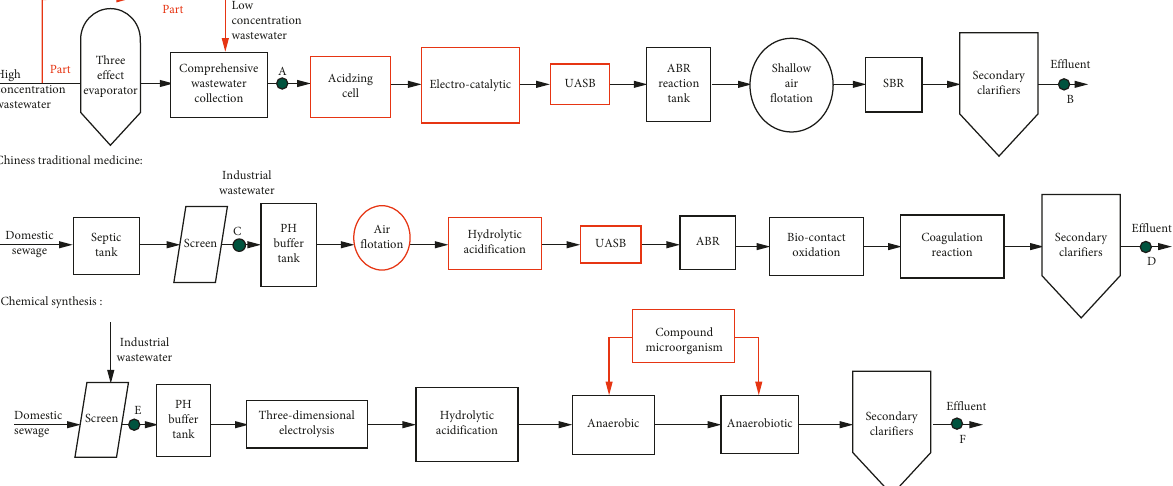
Figure 8: Schematic diagram of the improved processes developed for the three typical pharmaceutical wastewater treatment plants. Improvements to the process are indicated by the color red.